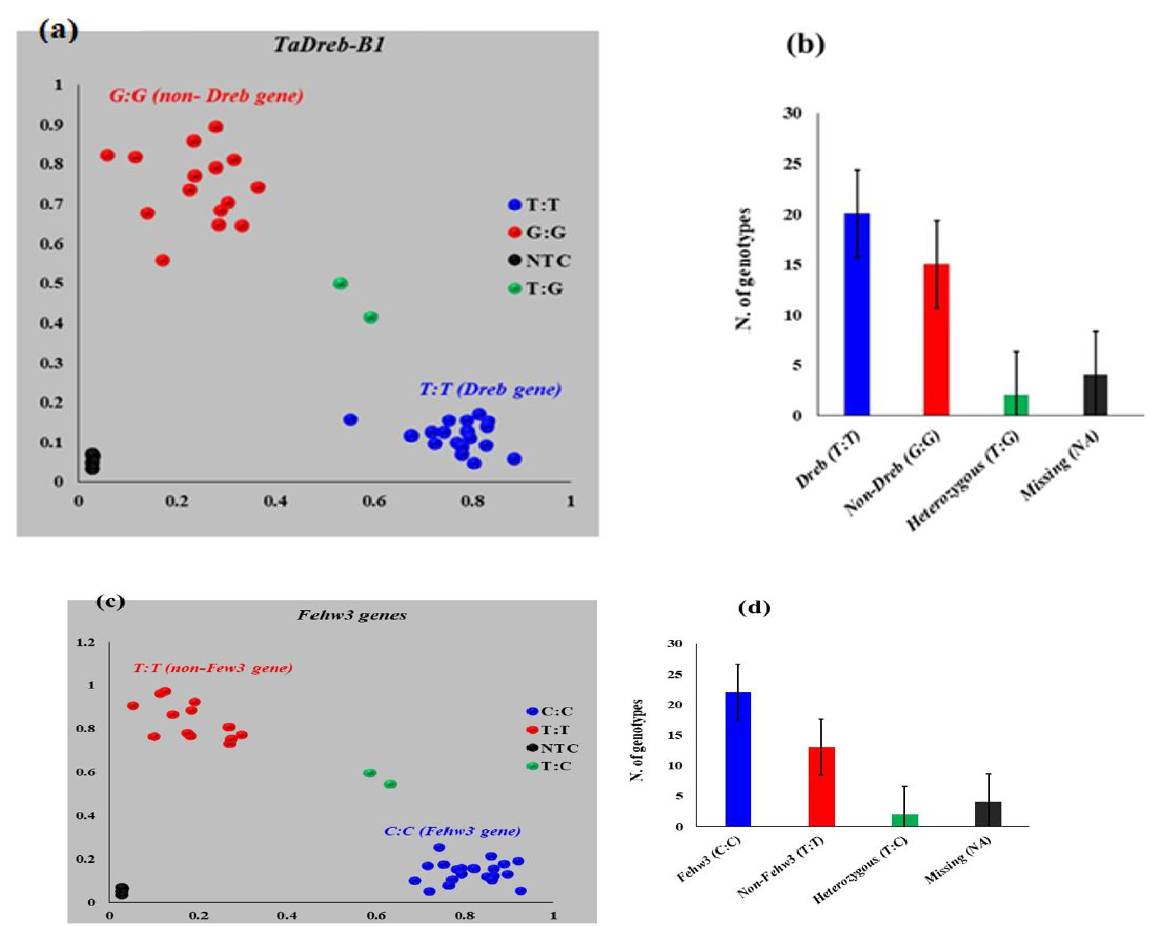
Figure 3. ( a , b ). Screening for TaDreb-B1 using Kompetitive allele-specific PCR (KASP) markers. ( c , d ). Screening for Fehw3 using Kompetitive allele-specific PCR (KASP) markers, where NTC refers water. to